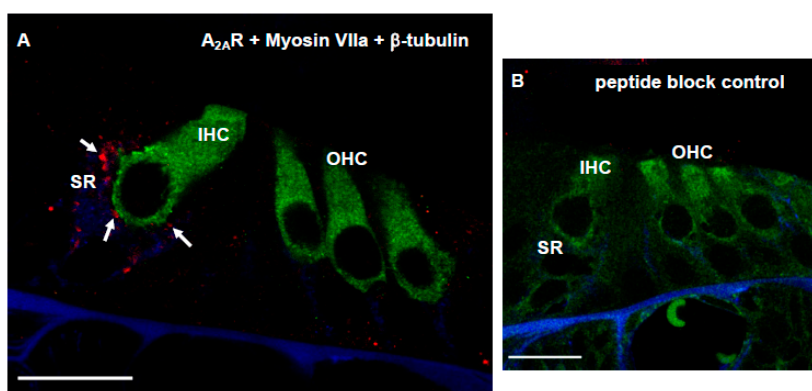
Figure 6. Confocal images of the P6 Wistar rat cochlea showing adenosine A 2A receptor (A 2A R) distribution at the synaptic region (SR) of the inner hair cells (arrows). ( A ) A 2a R immunofluorescence (red), Myosin VIIa immunolabelling of the sensory hair cells (green) and β -tubulin labelling of SGN neurites (blue). ( B ) Peptide block control. Images are representative of eight cochleae obtained from four animals. Scale bars, 20 µ